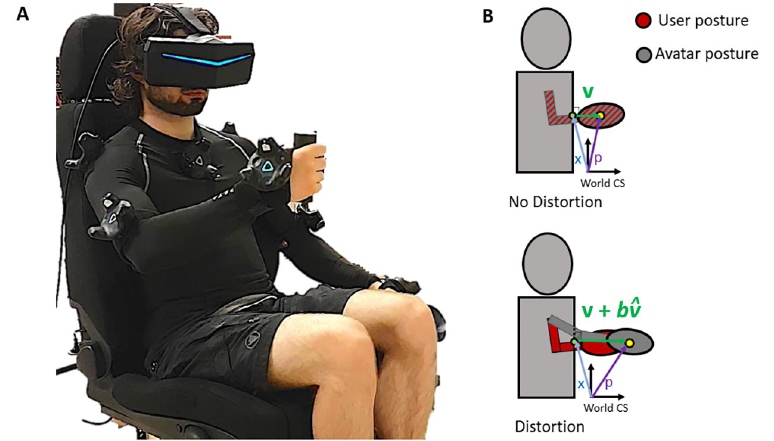
Fig 1. Left: Equipment: Participants have trackers on shoulders, elbows, and both hands, as well as a tracker on their chest. They hold a cylinder in the right hand and an HTC Vive Controller in the left hand. Right: Distortion of the subject’s hand position. No distortion: avatar and subject’s real posture coincide; Distortion: avatar’s posture. v is the relative displacement vector to the body part surface; ^ v the normalized displacement vector; b is the offset position between the real and virtual hand (5.5 cm in our